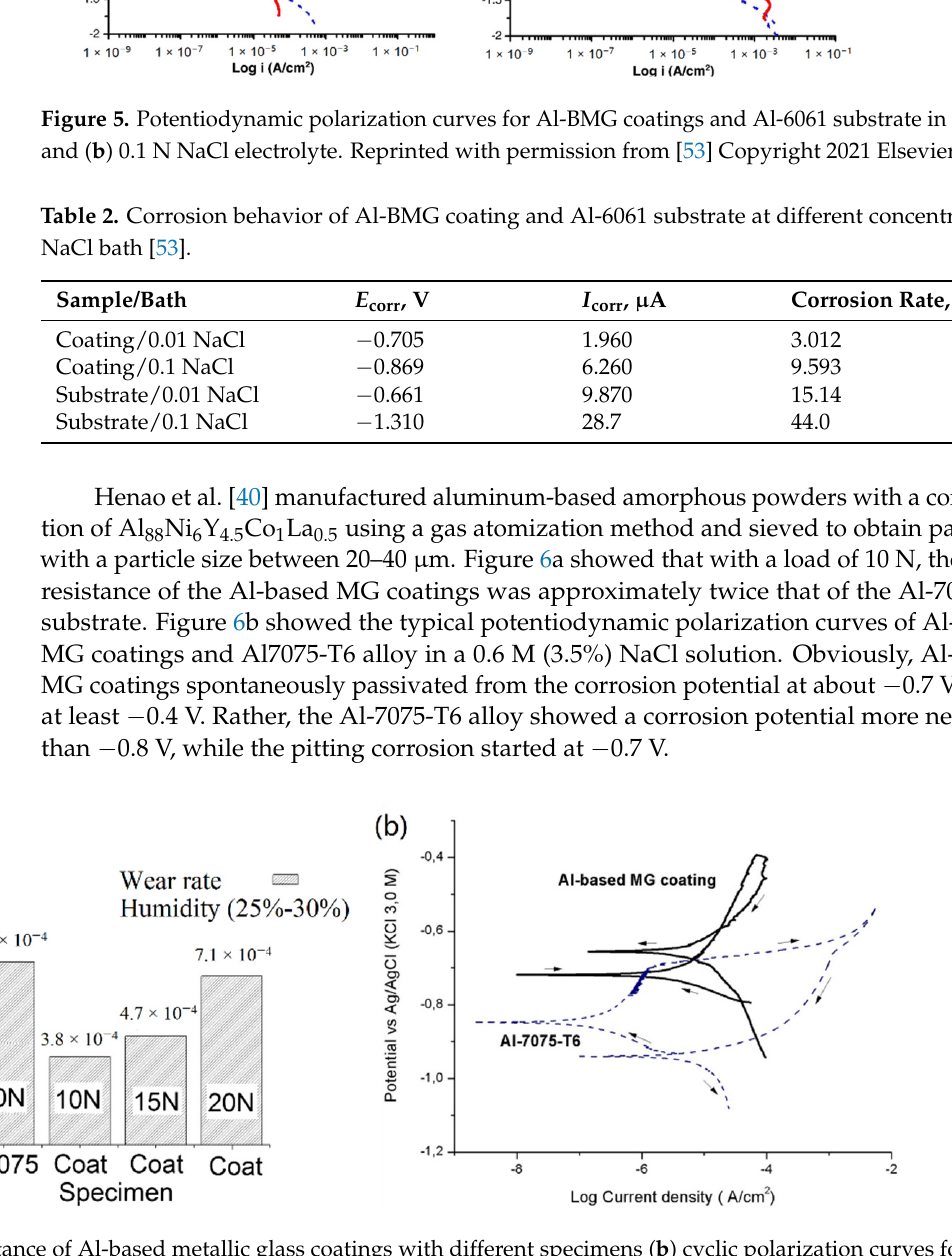
Figure 6. ( a ) Wear resistance of Al-based metallic glass coatings with different specimens ( b ) cyclic polarization curves for Al-based MG coatings and Al7075-T6 alloy. Reprinted with permission from [40] Copyright 2021 Elsevier.